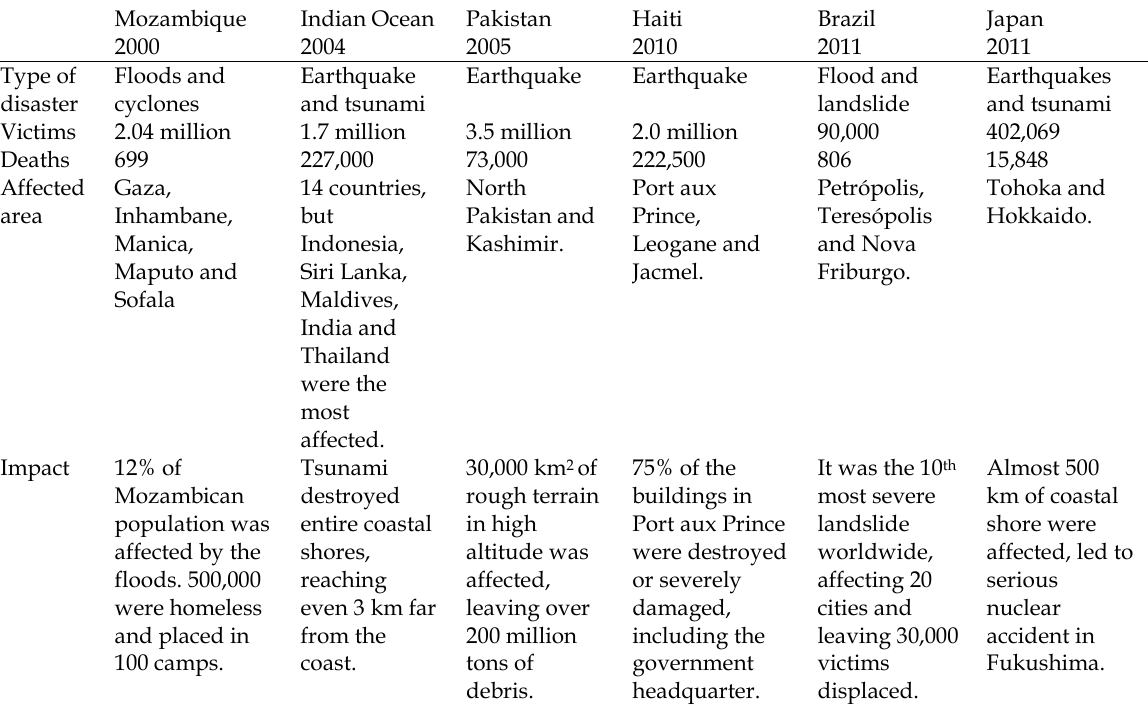
Table 1. Characteristics of the natural disasters